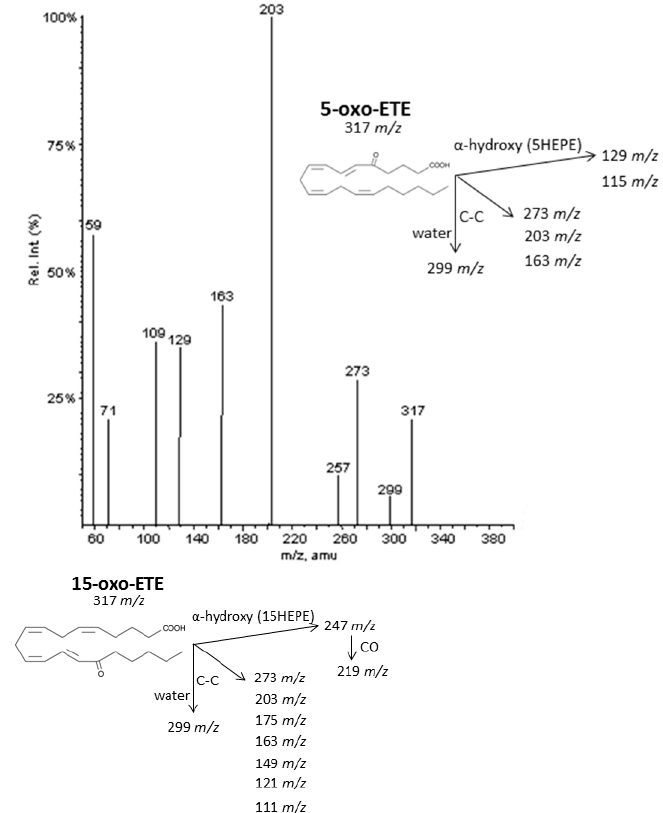
Figure 8. Fragmentation pattern suggested for ( a ) 12-oxoETE, ( b ) 5-oxoETE, and ( c ) 15-oxoETE (product ion spectrum at m/z 317 obtained from LIPID MAPS at CID 30V). A MS/MS spectrum was not found for 15oxoETE, thus, potential fragments for identification were suggested based on lipid structure.